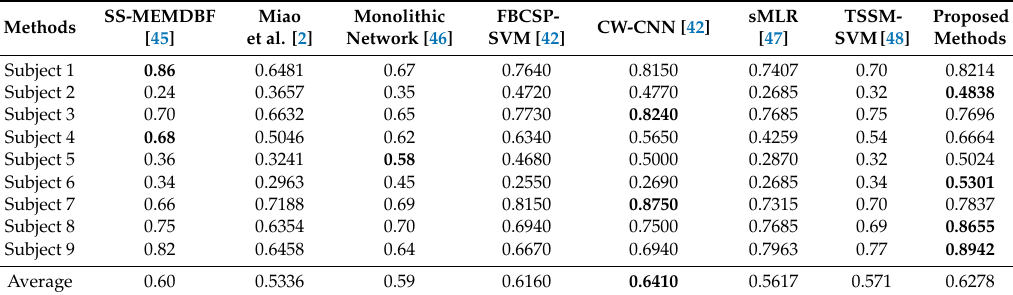
Table 3. Kappa value comparison with other published results applied on BCI competition IV dataset 2A. The best result for each subject is displayed in bold